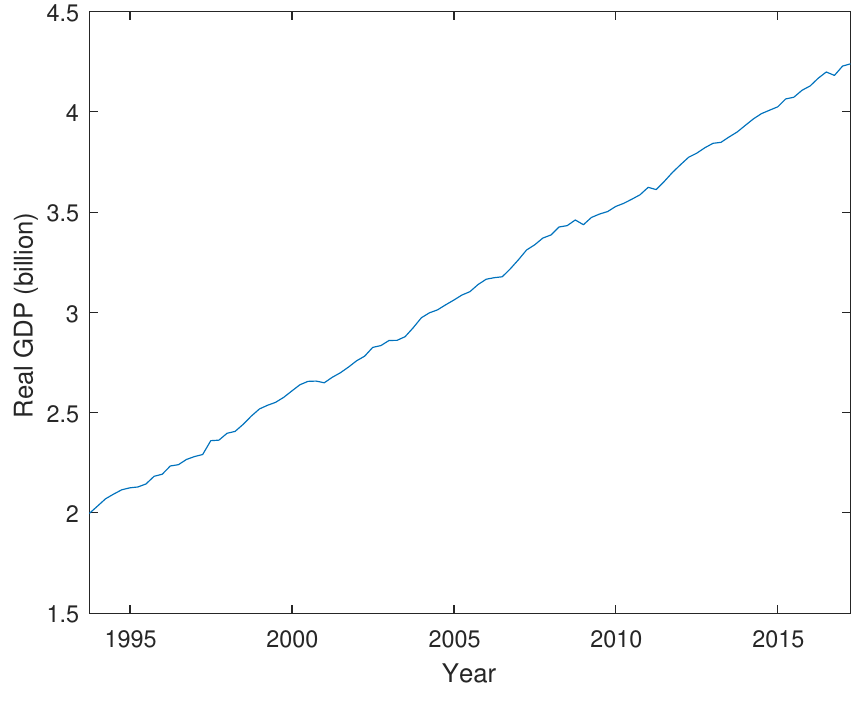
Figure A3. Real GDP (GDP).